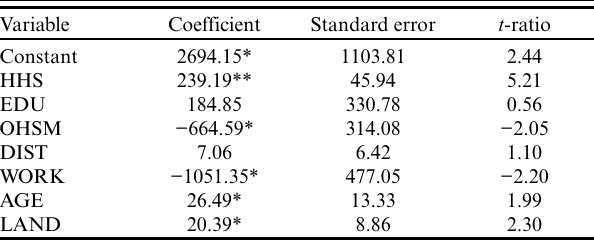
Table 5. Determinants of wetland-based income. Model R ² = 0.265, adjusted R ² = 0.222. See Table 2 for description of